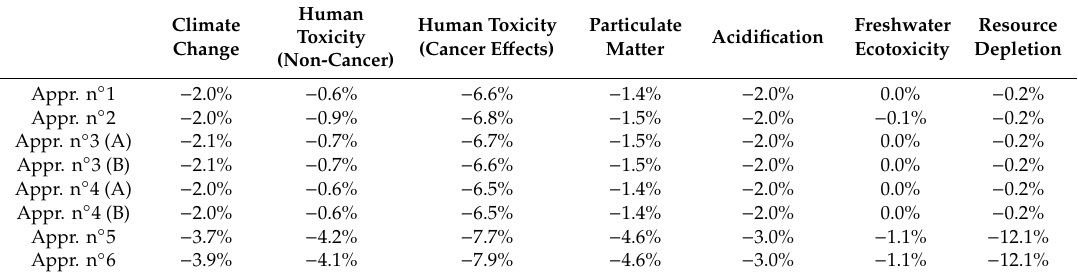
Table A1. Potential contribution of waste management to the environmental profile of electricity production with mono-Si modules.